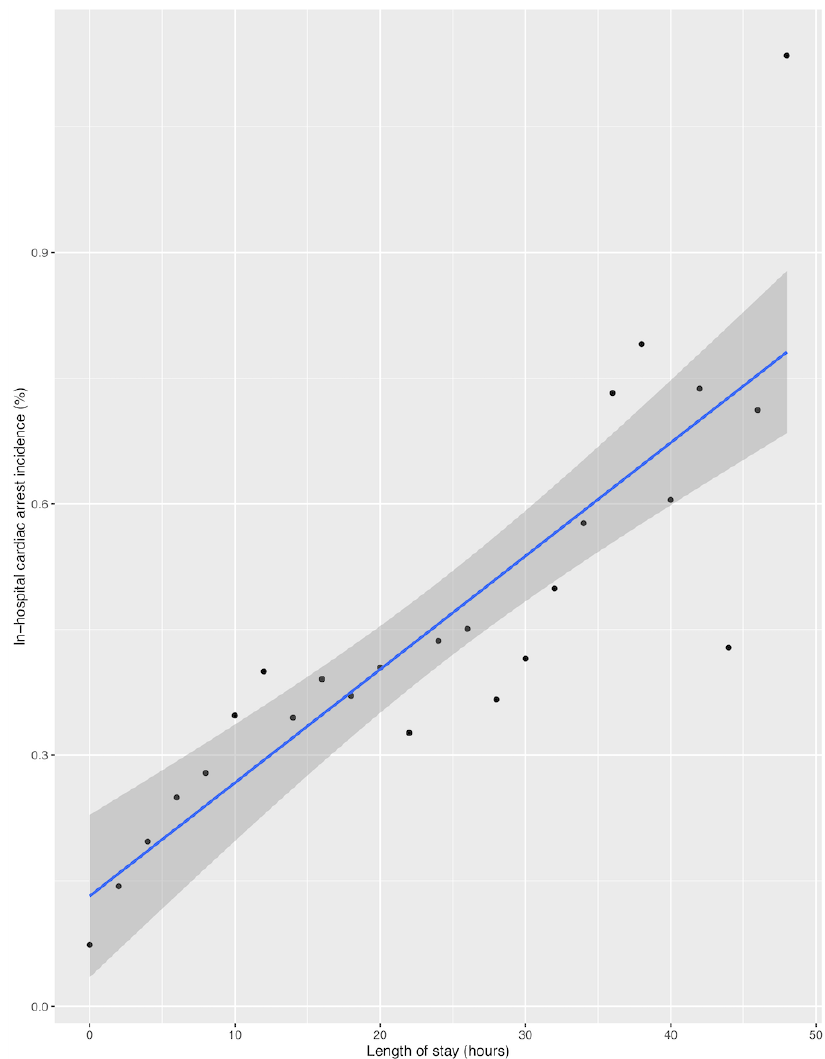
Figure 2. Correlation between length of stay in the emergency department and in-hospital cardiac arrest. Table 3. Multivariate analysis of factors associated with in-hospital cardiac arrest